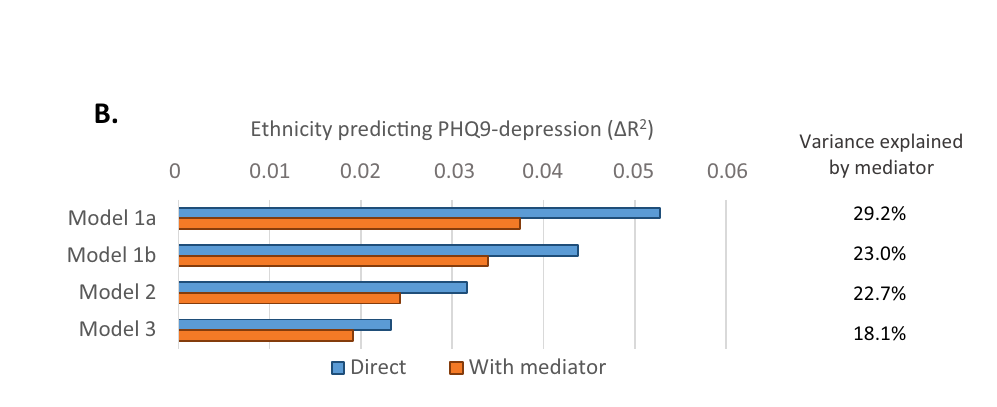
(models 1a to 3). Blue bars present Δ R 2 without β diversity incorporated as a mediator in the model, and the orange bars present Δ R 2 when mediation is assumed. The % in the table (right) indicate the attenuation of the direct effect by mediation. Regression models: We used two-sided linear regression analyses, no adjustments were made for multiple comparisons. Model 1a adjusted for age and gender; Model 1b added education; Model 2 further added behavioral factors (alcohol, smoking, exercise, BMI); Model 3 added GI disease, Diabetes, PPI use, Recent antibiotics, Diarrhea.All Δ R 2 p ≤ 0.001,exceptforethnicity-inclusive Model 3 ( p